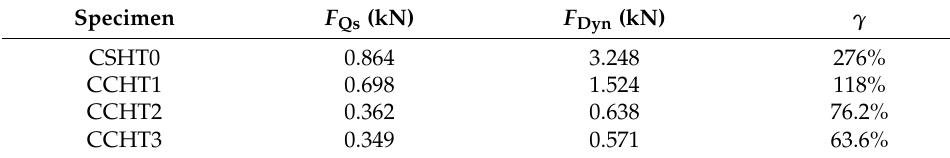
Table 3. Comparison between quasi-static and dynamic initial peak force.